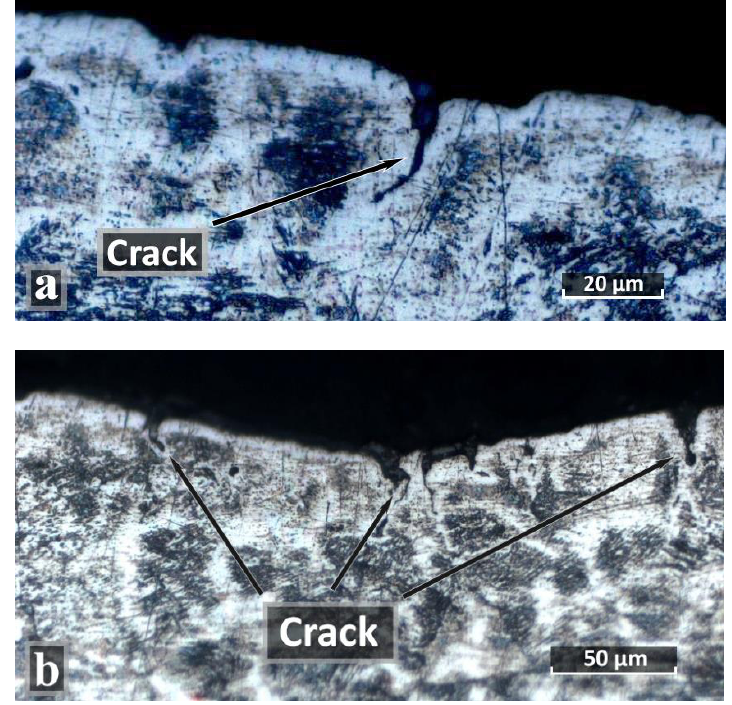
Figure 4. Microcracks in the central top part of the weld of a HT_2 sample. ( a ) magnification of 1000 times; ( b )magnification of 500 times.